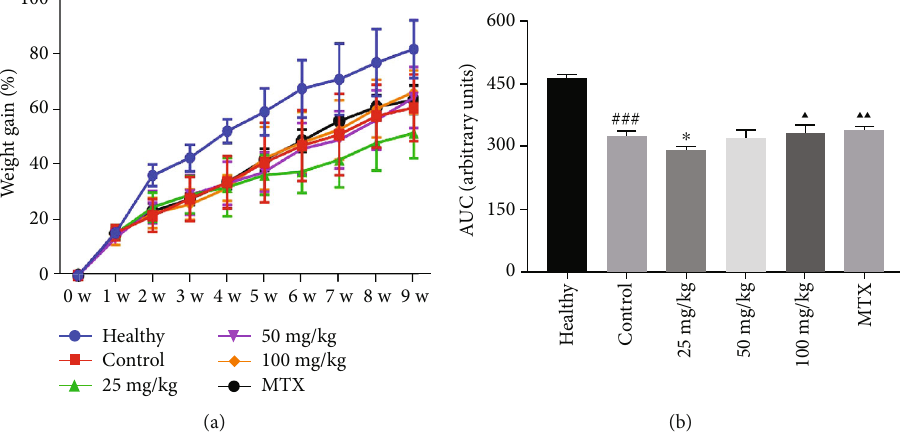
Figure 1: Changes in weight gain of the rats in each group. Healthy: healthy group; control: CIA control group; 25mg/kg: low dosage matrine group; 50 mg/kg: medium dosage matrine group; 100 mg/kg: high dosage matrine group; MTX: 2 mg/kg methotrexate group. Compared to the healthy group, ### P < 0 : 001 ; compared with the control group, ∗ P < 0 : 05 ; compared to the 25 mg/kg group, ▲ P < 0 : 05 ; ▲▲ P < 0 : 01 .